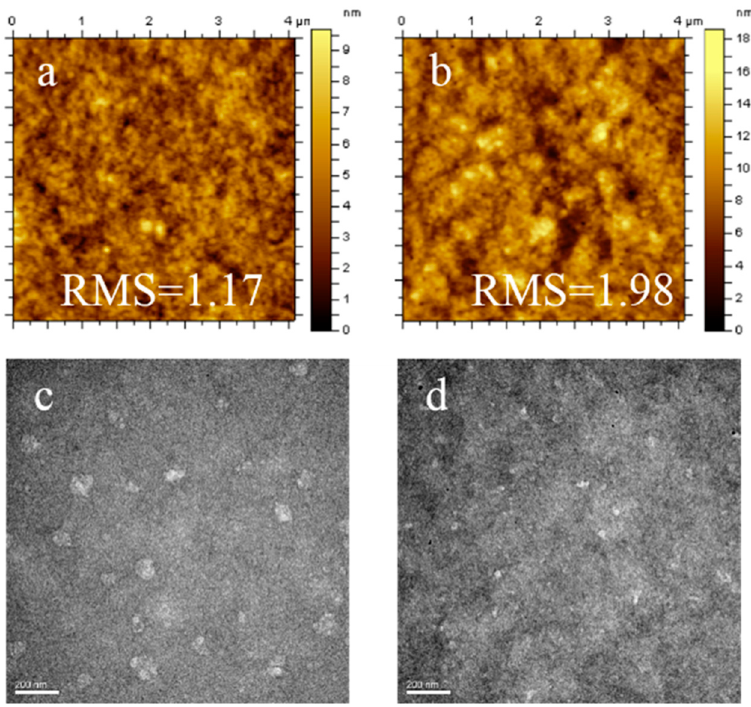
Figure 7. AFM images of ( a ) PBDTNS-FTAZ:ITIC ( b ) PBDTBPS-FTAZ:ITIC and TEM images of ( c ) PBDTNS-FTAZ:ITIC and ( d ) PBDTBPS-FTAZ:ITIC.